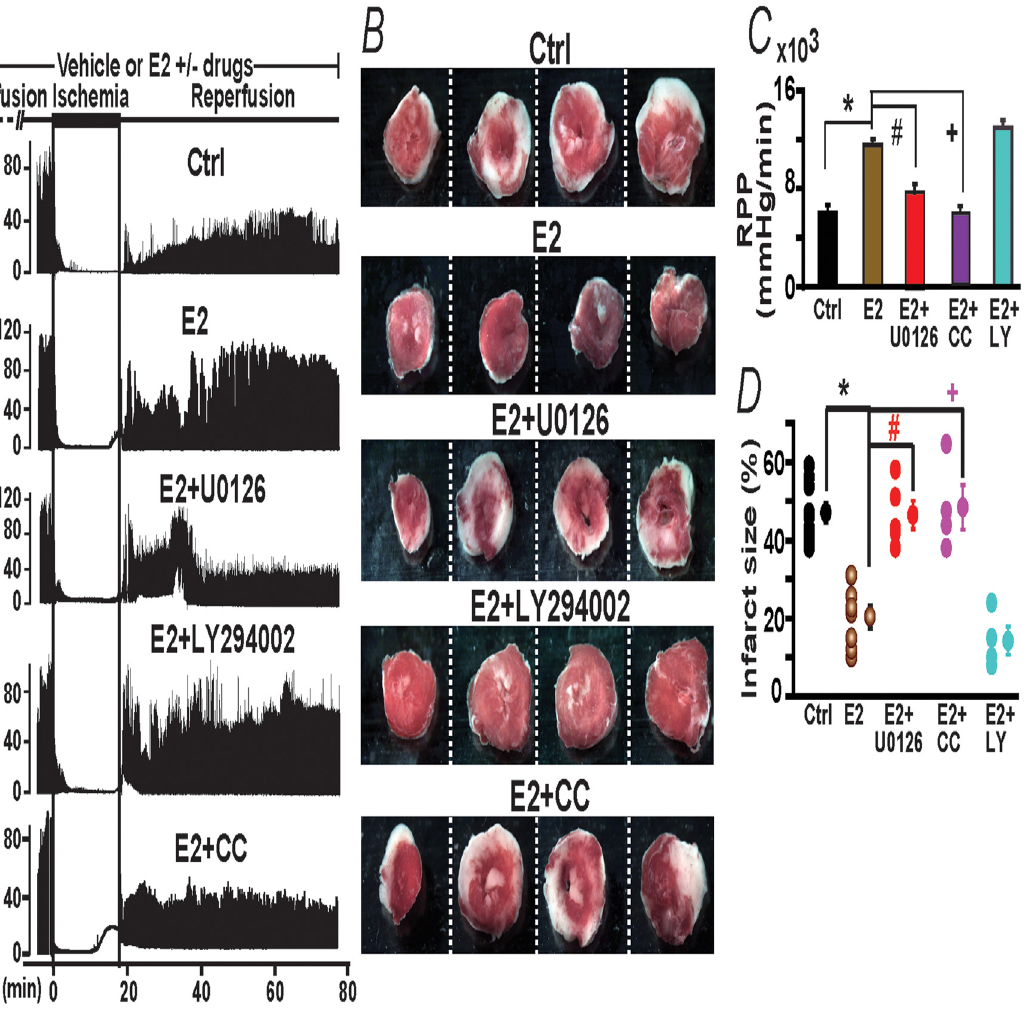
Fig 8. E2-induced cardiac protection against I/R injury is prevented by inhibitors of PKC translocation and MEK 1/2 but not by a PI-3K inhibitor. A. Time course of LVDP changes by E2 +/- drugs during the I/R protocol (scheme at top). E2-induced protection during reperfusion was diminished by cotreatment during the whole protocol with MEK 1/2 inhibitor, U0126 and with PKC translocation inhibitor, chelerythrine chloride (CC) but not with PI-3K inhibitor, LY294002. B. Heart sections of same heart in each condition stained at the end of the reperfusion period. White areas are infarcted zones. LY294002 co-treatment failed to inhibit E2-mediated prevention of heart infarct. C,D,E. Mean values of Rate Pressure Product (RPP), and % infarct size in control hearts (ctrl, perfused with vehicle) and hearts treated with E2 (40 nM), E2 (40 nM)+U0126 (1 μ M), E2 (40 nM)+LY294002 (10 μ M), and E2 (40 nM) +CC (1 μ M). RPP and dP/dt max were obtained by averaging the last 2 min of reperfusion. Values are expressed as mean ± SEM; * , P < 0.05 E2-treated group versus control (n = 6-8/group); #, P < 0.05 E2+U0126 versus E2-treated group; +, P < 0.05 E2+CC versus E2-treated group (n = 4-7/group). Functional values as a function of time are given in Table 2. All values were obtained using WT male